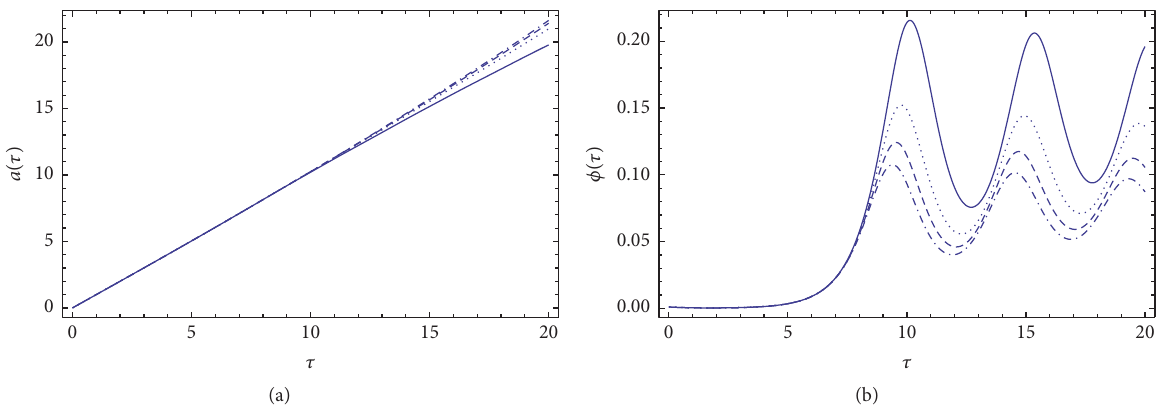
Figure 6: Variation of the scale factor of the Universe (a) and of the scalar field (b) as a function of the dimensionless time 𝜏 for the scalar field with Higgs type self-interaction potential, for different values of the parameter 𝜂 : 𝜂 = 10 (solid curve), 𝜂 = 20 (dotted curve), 𝜂 = 30 (dashed curve), and 𝜂 = 40 (dashed dotted curve).